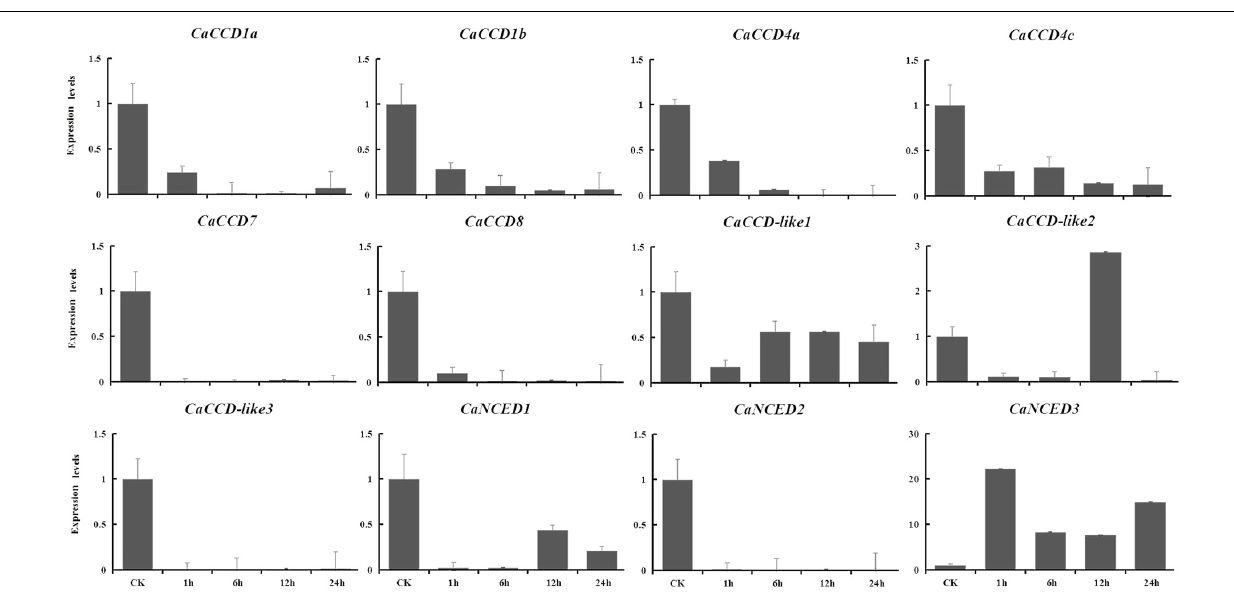
FIGURE 10 | Expression patterns of CaCCO genes in response to salt stress at different time